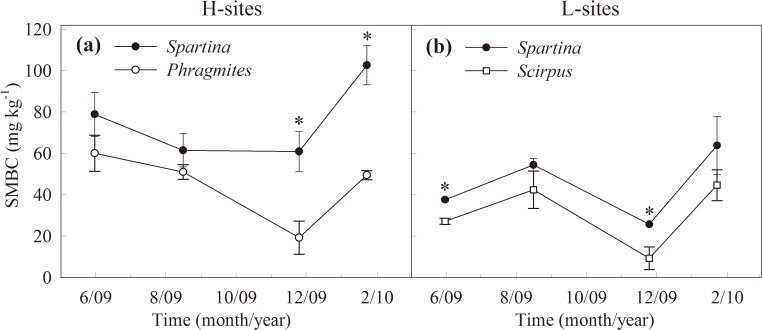
Soil microbial biomass carbon in different plant stands.Seasonal variations in soil microbial biomass carbon (SMBC) content (0–20 cm deep) in the S. alterniflora (Spartina) and P. australis (Phragmites) stands in the H-sites, and S. alterniflora and S. mariqueter (Scirpus) stands in the L-sites. Bars represent mean ± SE (n = 9), asterisks indicate significant differences (P < 0.05) between means of different stands.